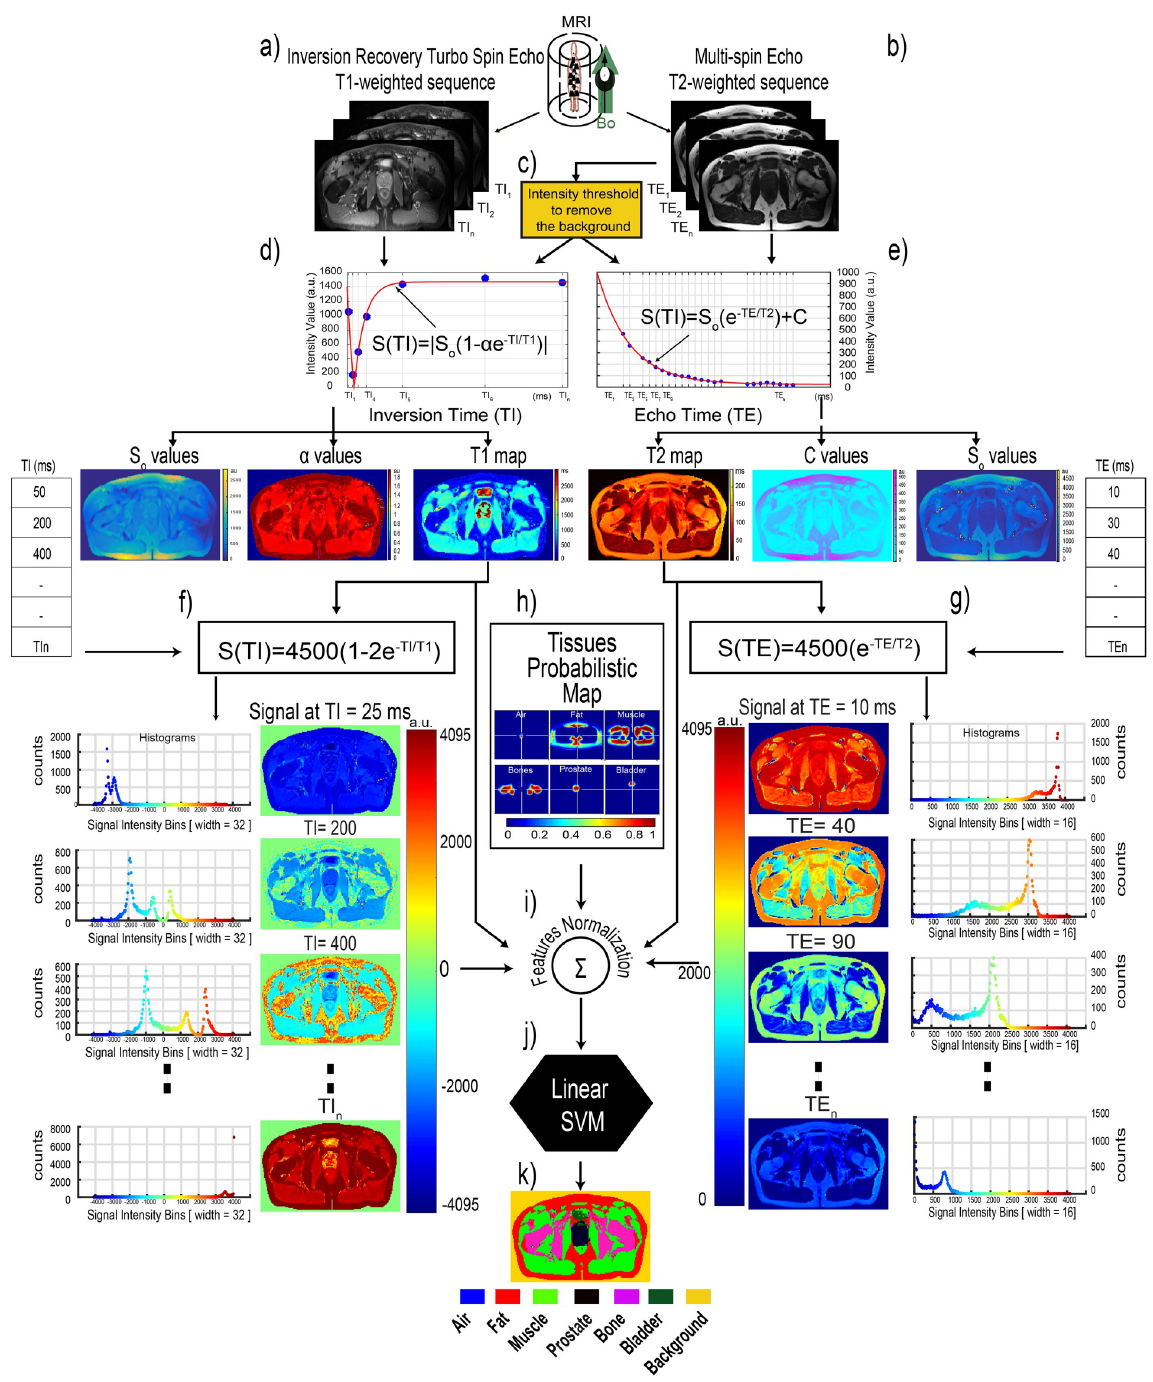
Fig 1. Pipeline of the segmentation and classification process using the SVM classifier. After obtaining the T 1 - and T 2 -weighted images (a-b) from their corresponding sequences, the body region is found using a threshold method on the T 2 -weighted images (c). Then, the fit procedure is applied to obtain the relaxation maps and other different variables from the received signal model (d-e). These variables are then used to generate the synthetic T 1 - and synthetic T 2 -weighted images (f-g). Later, an independent process using the training data is used to generate tissues probabilistic maps, i.e. the probability of a voxel belonging to different tissues (h). At this point, all feature descriptors are normalized (i) to be used by the multi-class SVM classifier (j), which predicts the different classes (k).